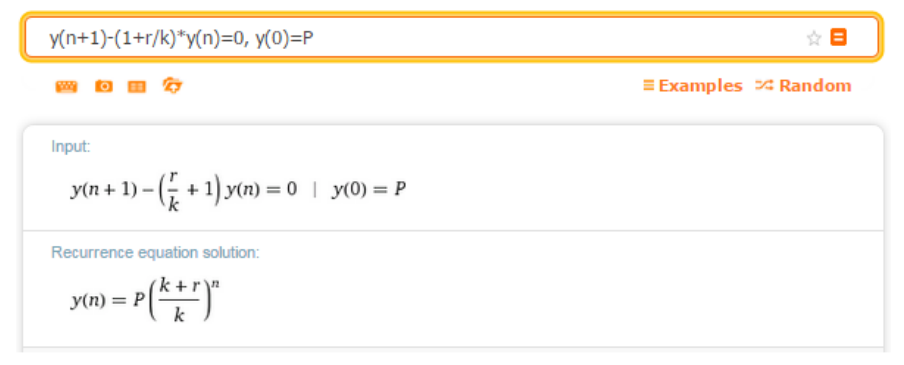
Fig. 1. Compound interest